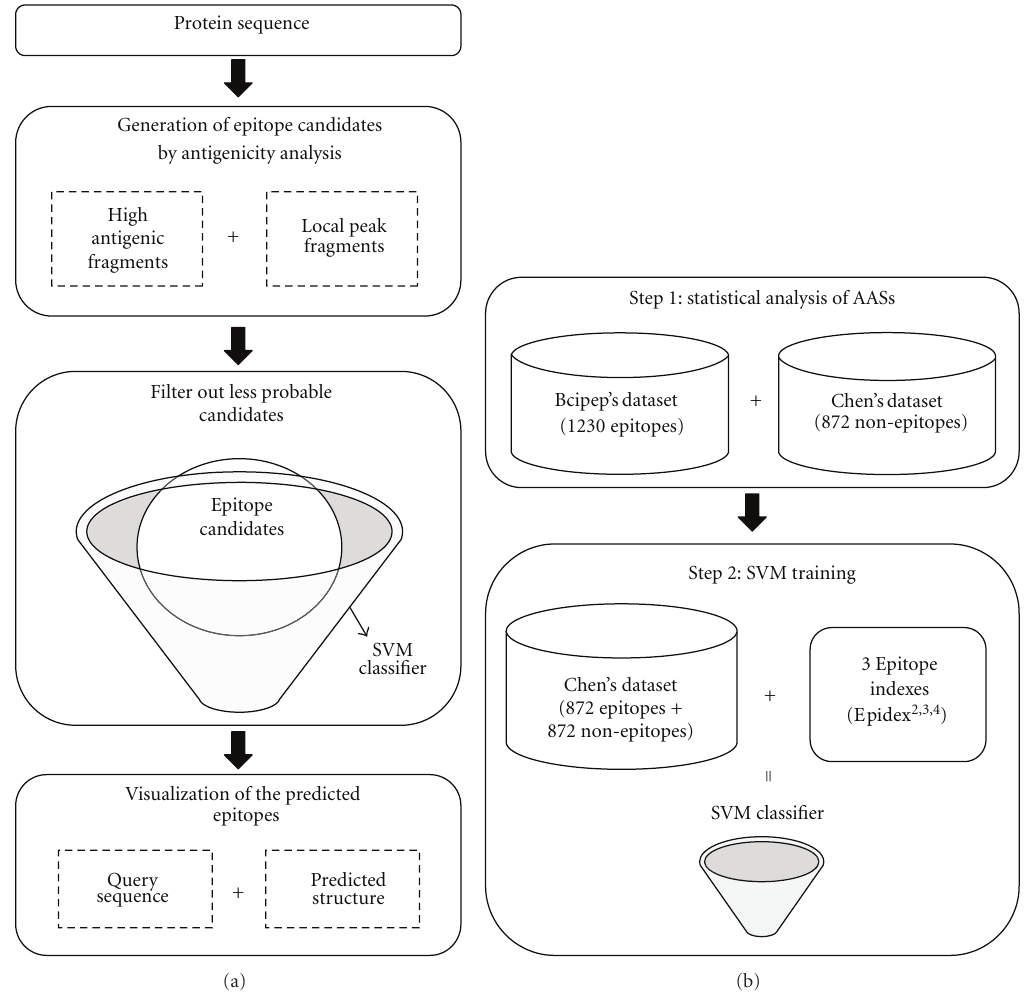
Figure 1: The design of LEPS. (a) Step 1(a): primitive epitope candidates with globally and locally high antigenicity were extracted by calculating weighting coe ffi cients for various physicochemical propensities of each amino acid. After the filtering process with the SVM classifier (step 2(a)), predicted epitopes were highlighted (step 3(a)) in the query sequence and the simulated structure. (b) Step 1(b): 1230 experimentally verified epitopes and 872 non-epitopes were analyzed to determine the statistical characteristics of AASs. Step 2(b): subsequently, epitope indexes of 872 epitopes and 872 non-epitopes were used to train the SVM model to predict candidate epitopes based on the statistical characteristics defined in step